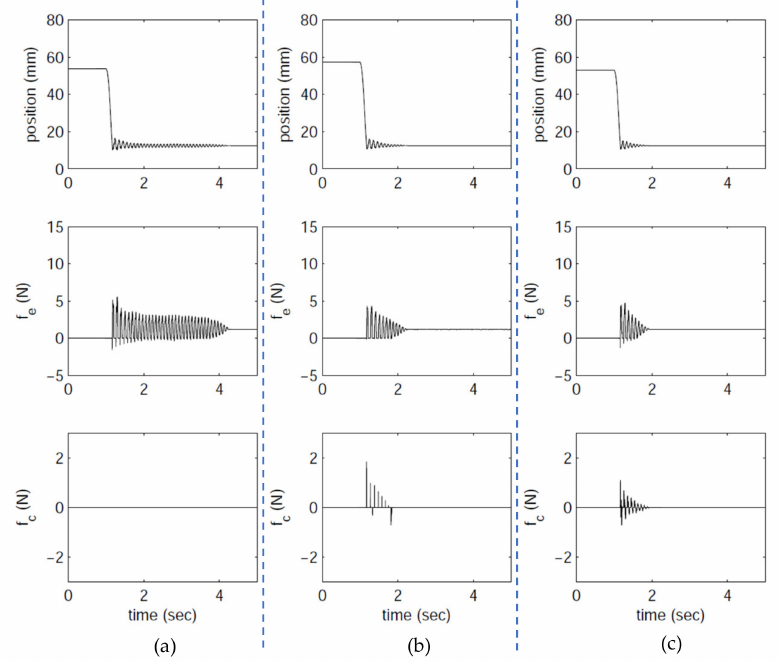
Figure 11. Experimental results at K = 2000 N/m, B = − 7 Ns/m, α = 3 Ns/m: ( a ) controller free, ( b ) the basic passivity controller, and ( c ) the